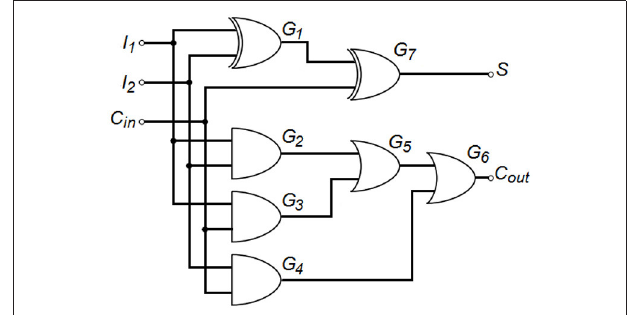
FIGURE 7 | Logic diagram of the full adder whose truth table is shown in Table 5 .